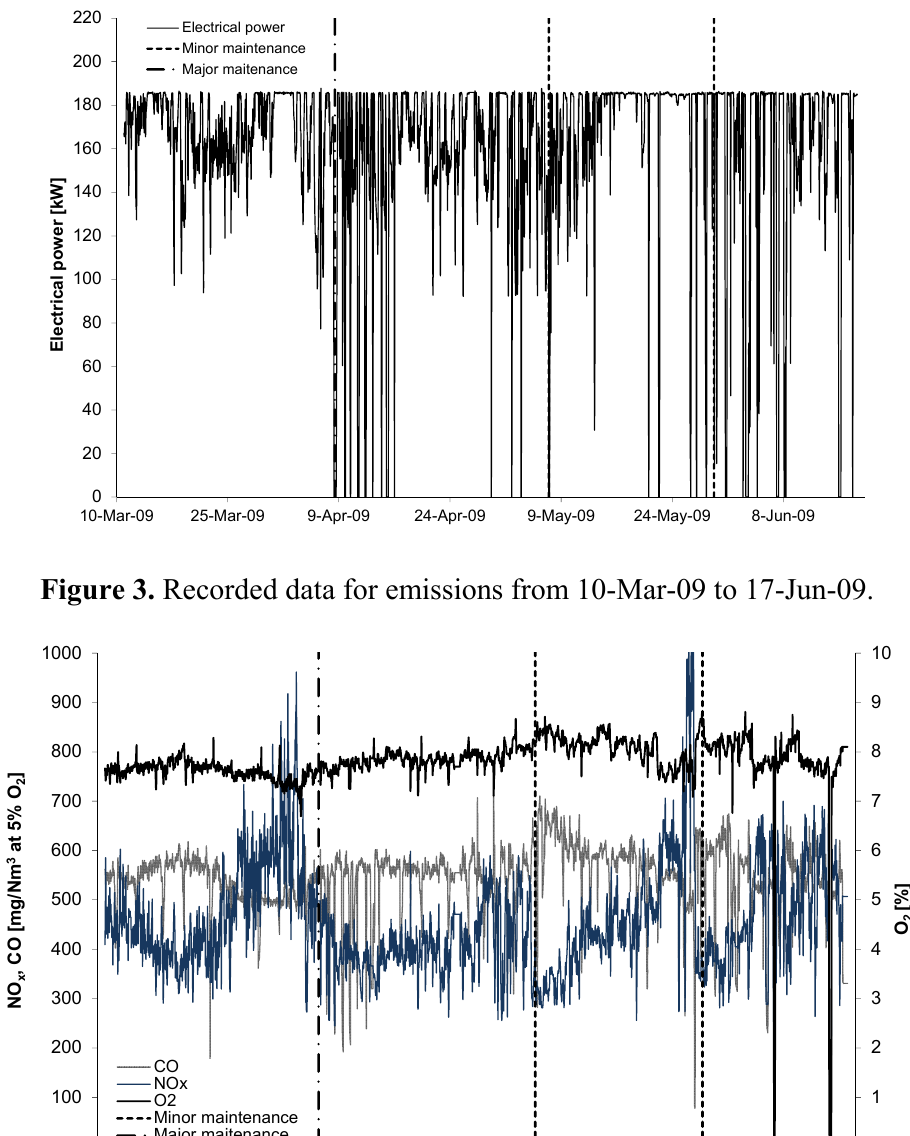
Figure 2. Recorded data for electrical power from 10-Mar-09 to 17-Jun-09.